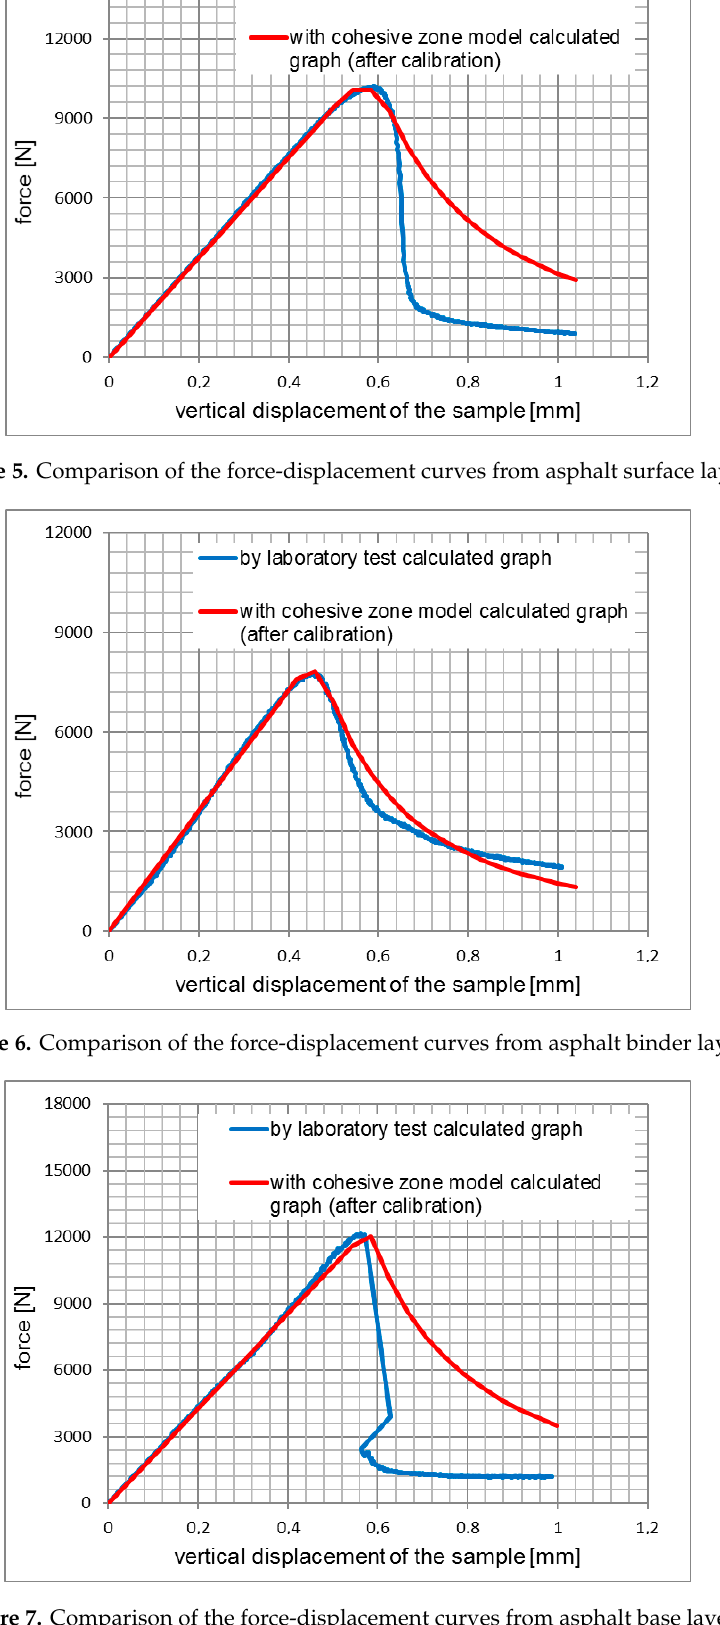
Figure 7. Comparison of the force-displacement curves from asphalt base